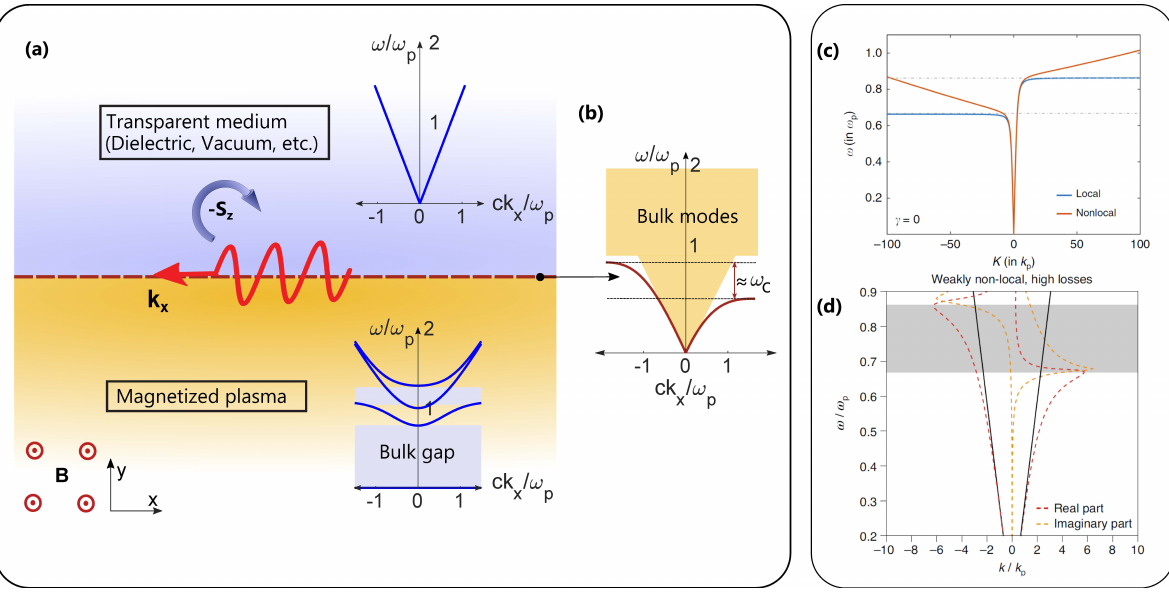
Figure 4. Unidirectional surface plasmon-polariton modes on an interface between a semi-infinite magnetized plasmonic medium and a transparent medium, in the plane orthogonal to the bias. ( a ) Geometry of the interface in the plane orthogonal to the applied magnetic field (geometry, bias, and SPP fields are invariant in the out-of-plane (z) direction). Inset: Typical bulk-mode dispersions. The blue arrow marks the direction of rotation of the electric field vector in the xy plane, associated with a transverse spin for the propagating SPP. ( b ) Typical SPP dispersion calculated using a standard local Drude model. ( c ) SPP dispersion calculated using a non-local hydrodynamic model for the plasma. ( d ) SPP dispersion in a weakly non-local plasma with high losses. ( c , d ) reproduced with permission from [46,57], respectively.